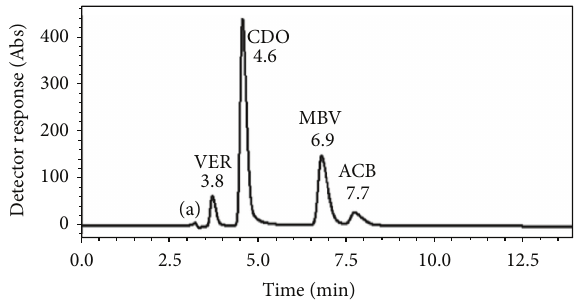
Figure 3: Representative chromatogram showing good separa- tion of CDO (50.0 𝜇 g/mL), MBV (100.0 𝜇 g/mL), veratric acid (10.0 𝜇 g/mL), and ACB (10.0 𝜇 g/mL), where (a) is the solvent